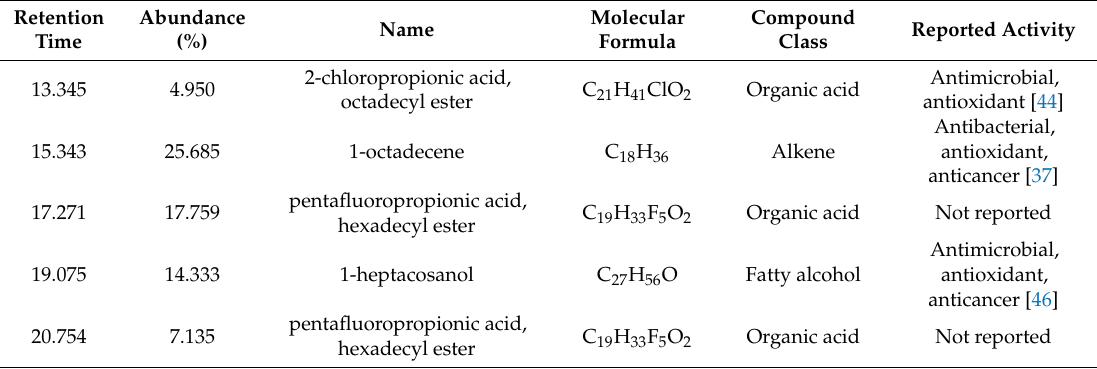
Table 4. Active compounds identified in the hexane fraction of Nyctanthes arbor-tristis aqueous flower extract by gas chromatography / mass spectrometry (GC / MS) analysis.